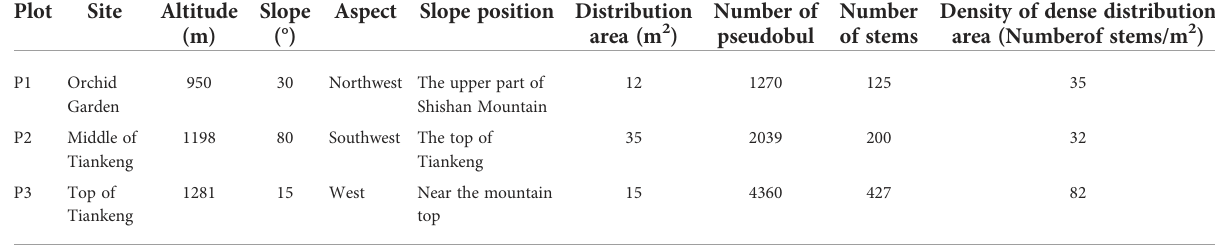
TABLE 1 Habitat and population pro fi le of Bulbophyllum tianguii .